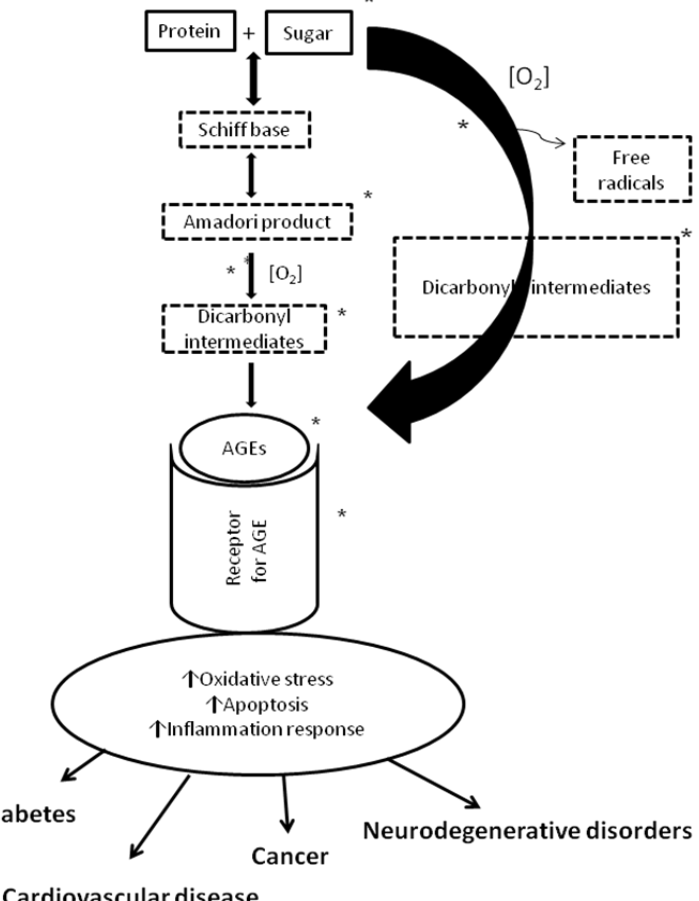
Figure 2. Formation of Advanced Glycation Endproducts (AGEs) and the sites where flavonoids may inhibit their formation (*). These include monosaccharide autoxidation, glycation, glycoxidation, as well as AGE receptor binding, which results in the activation and release of inflammation